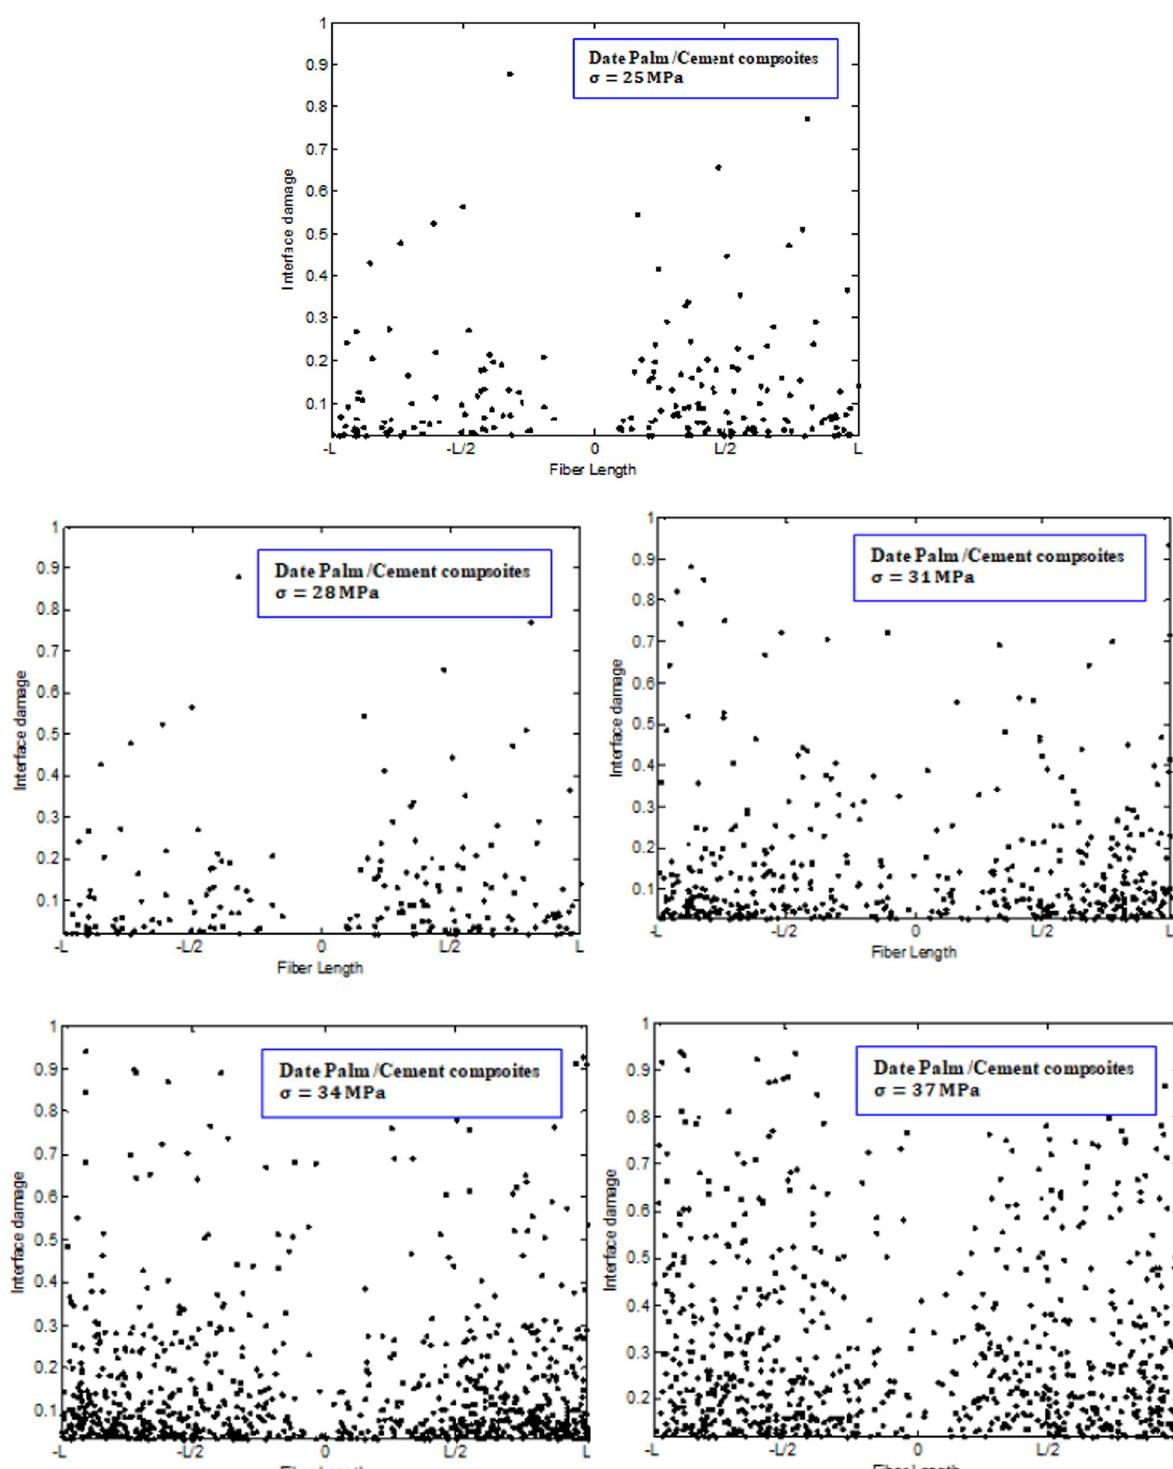
Fig. 5 Fiber-mortar interface damage of Date Palm/Cement